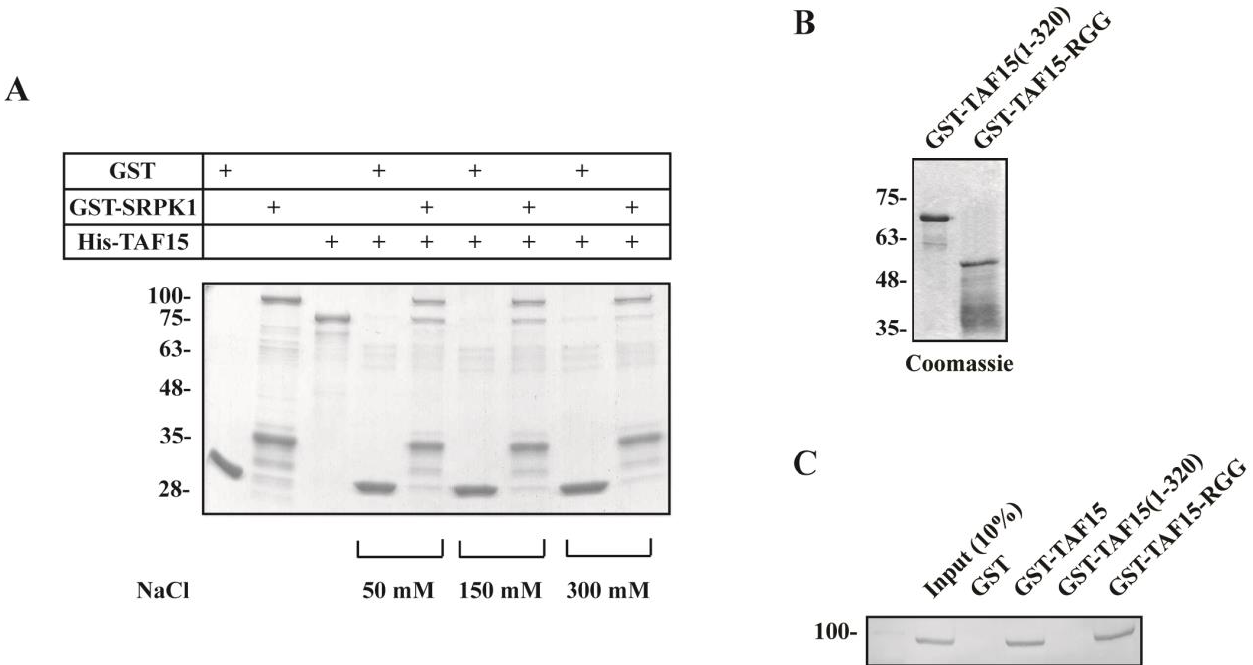
Figure 3. The C-terminal RGG domain of TAF15 interacts with SRPK1. ( A ) Pull-down assays using His-TAF15 and GST-SRPK1 in the presence of 50, 150, and 300 mM NaCl. GST was included as a control. Bound His-TAF15 was detected by Coomassie blue staining. ( B ) SDS-PAGE analysis and Coomassie blue staining of bacterially produced GST-TAF15(1 – 320) and GST-TAF15-RGG. The full-length GST-TAF15-RGG migrates with an apparent molecular mass of approximately 53 kDa. The lower bands represent degradation products. ( C ) GST, GST-TAF15, GST-TAF15(1 – 320), and GST-TAF15-RGG immobilized on glutathione-Sepharose beads were incubated with HeLa cell extracts. The sediments were harvested, washed three times with cell extraction buffer, and analyzed by SDS-PAGE. Bound SRPK1 was detected by Western blotting using the anti-SRPK1 monoclonal antibody. Numbers on the left indicate molecular masses (in kDa).